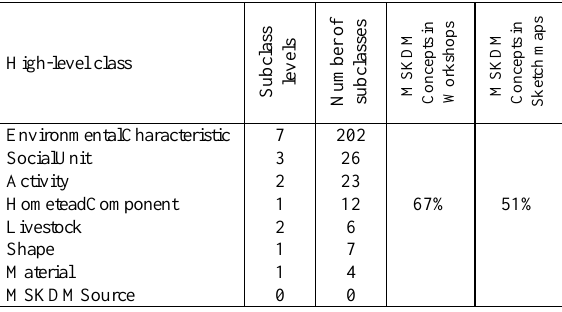
Table 1. Number of subclasses and inheritance depth for